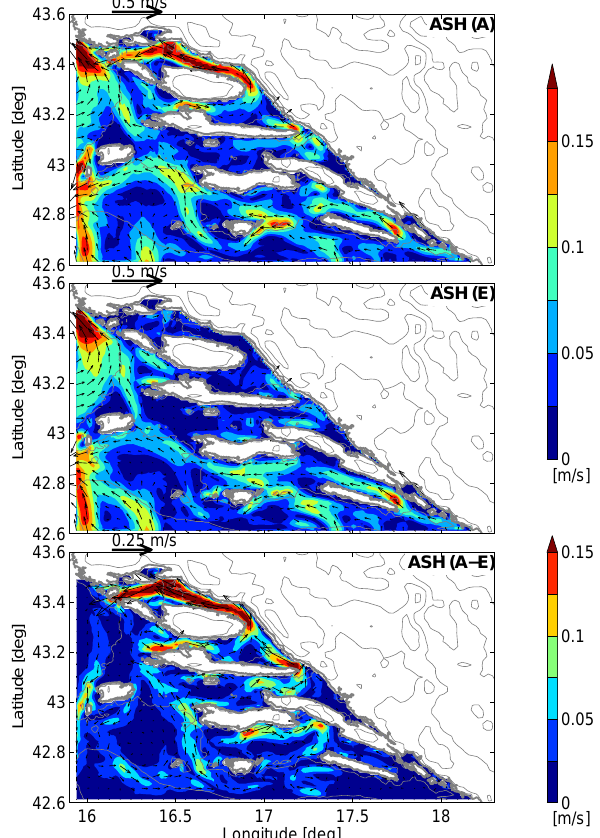
Fig. 4. Mean ASHELF-2 modeled vertically averaged currents for the B2 Bora period (Table 1) obtained with ALADIN and ECMWF forcing (top and center panels, respectively) and the differences be- tween these two (bottom panel). Additionally, the magnitudes of vector differences | ALADIN-ECMWF | are shown in